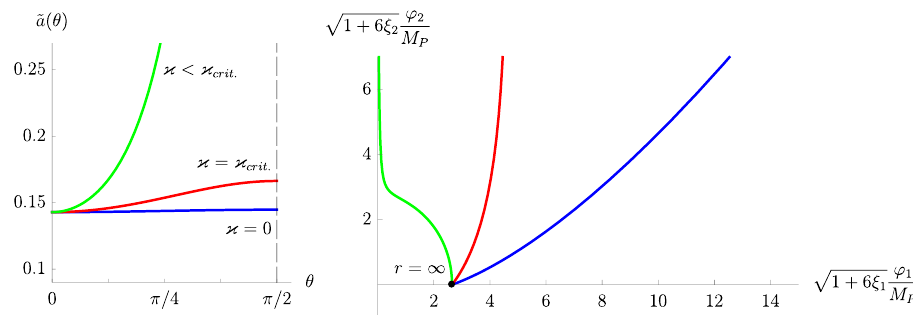
Figure 4 . The singular instantons of the model (4.21)|(4.24) with a ( (cid:18) ) replaced by ~ a ( (cid:18) ) according to eq. (4.46), and with { varied. The left panel shows the function ~ a ( (cid:18) ). In the limit { = 0, the original model is reproduced. The critical value, { = { crit : , corresponds to the case when (cid:17) = (cid:13) in eqs. (4.39), see appendix C for details. The value below the critical, { < { crit : , is chosen so that ~ a ( (cid:18) 0 ) (cid:17) ~ a 0 = 100. This value lies close to the positivity bound in eq. (4.47). The right panel shows the corresponding instanton solutions. At { = 0, the instanton studied in (cid:12)gures 2 and 3 is reproduced. The parameters of the model are (cid:24) 1 = 1, (cid:24) 2 = 1 : 1 and (cid:21) =